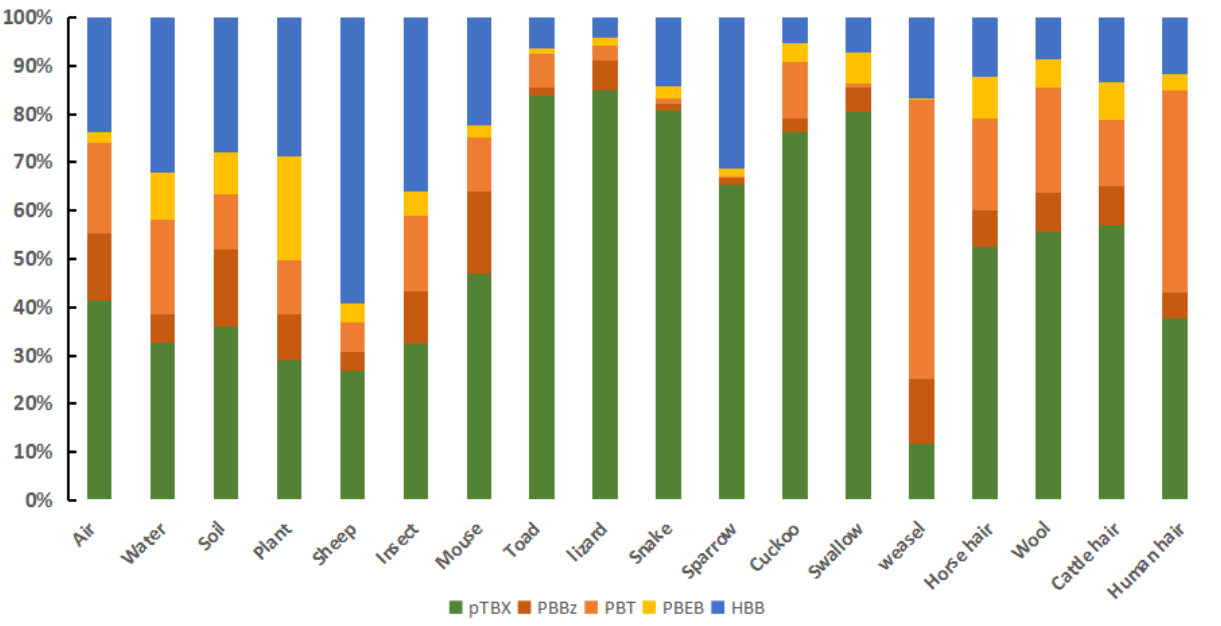
human hair, mouse, sheep, weasel, and wool) were on the lower right of the map, and the datapoints for the abiotic environmental media samples (air, soil, and water), grass samples, and insect samples were on the upper right of the map. This indicated that the NBFRs were bioaccumulated to different extents in the amphibians, reptiles and birds, and in the other mammals. This may have been related to the different diet habits and metabolic modes of the different